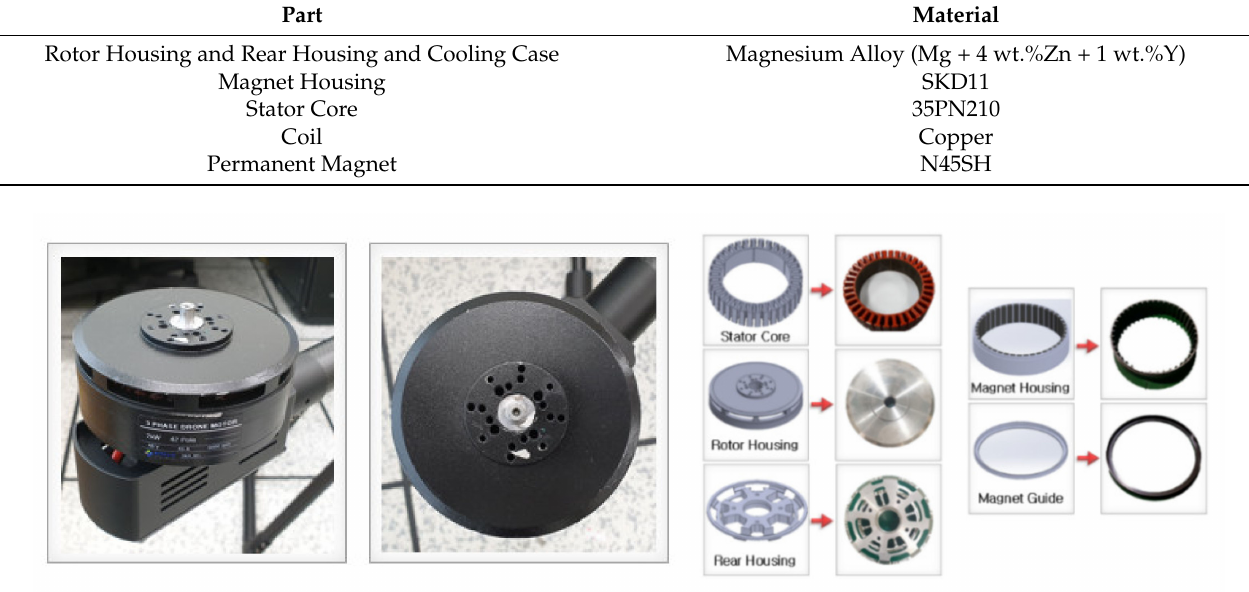
Figure 7. Prototype parts and final